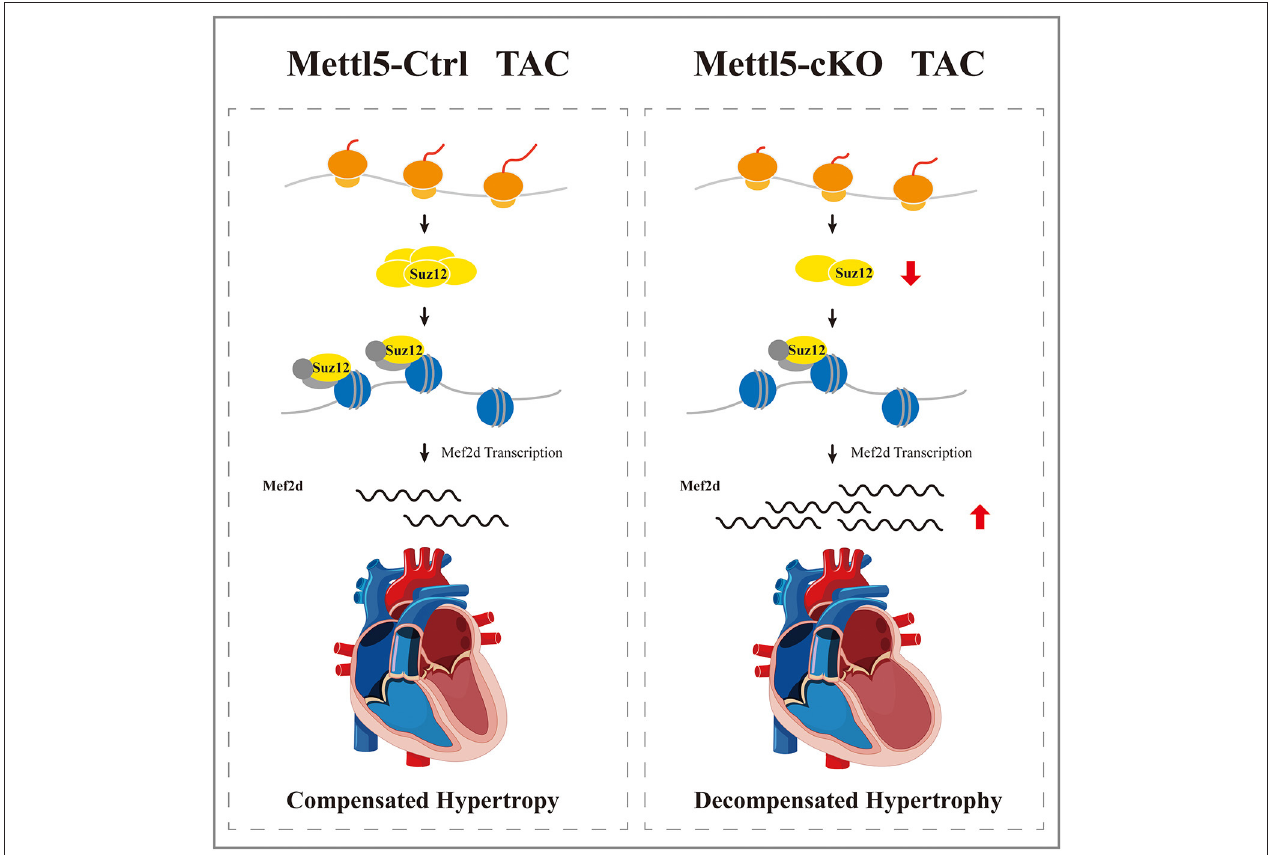
FIGURE 6 | A proposed working model of METTL5 in cardiac